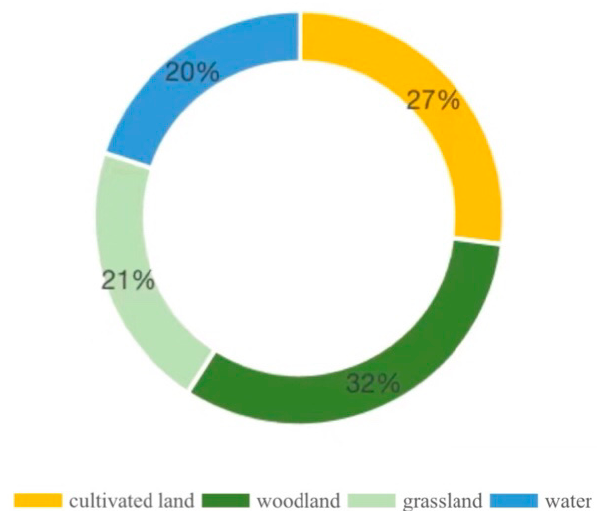
Figure 3. Weights of different indicators considered in this study.